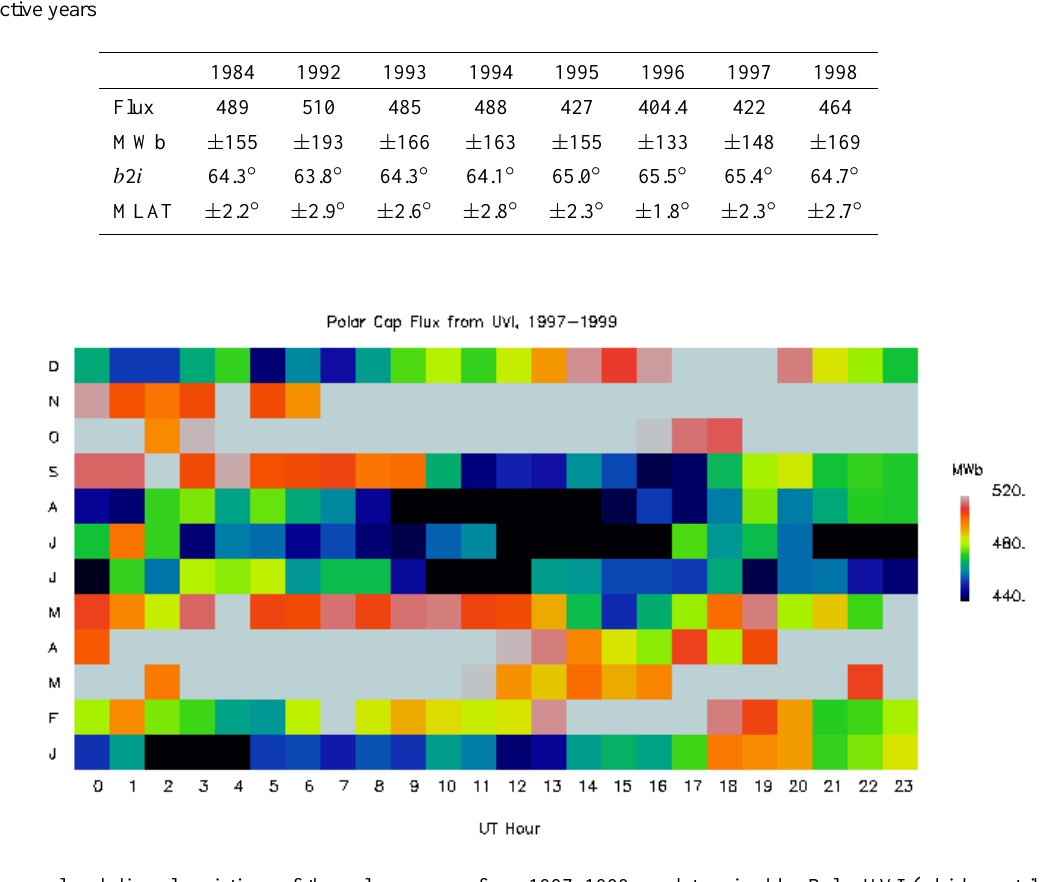
indicate more active